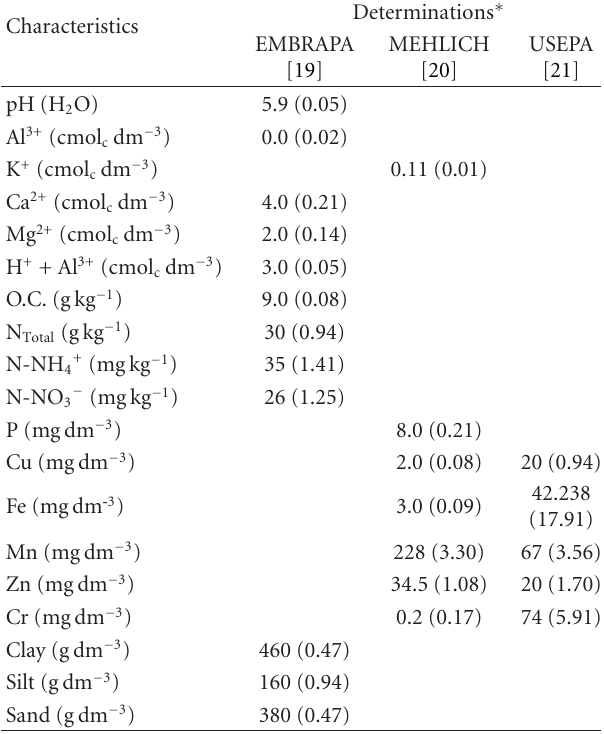
Table 2: Chemical and physical soil characteristics before elephant- grass